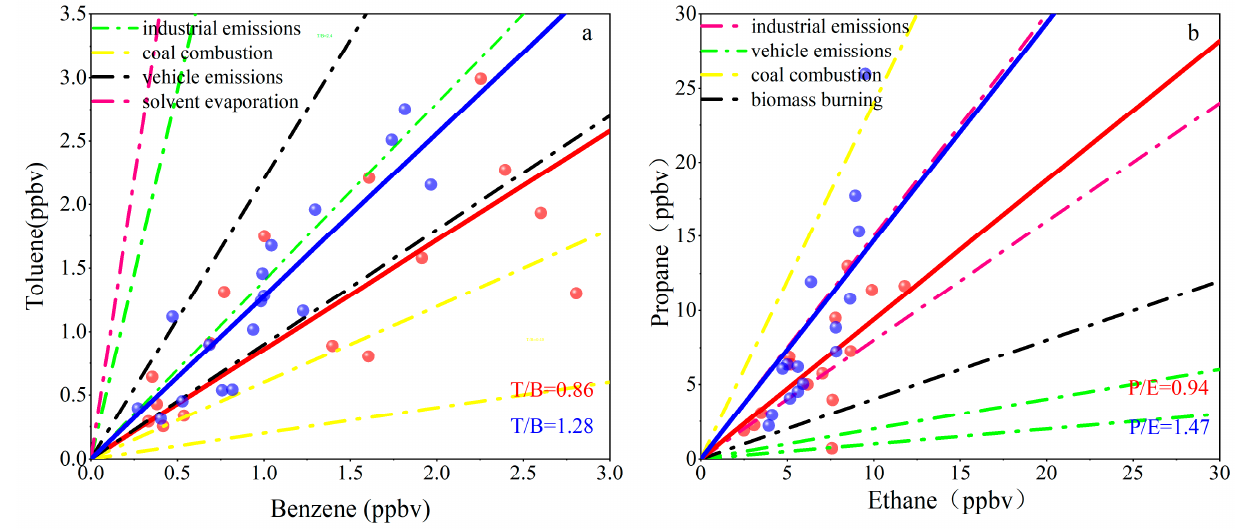
Figure 6. Ratios of toluene/benzene and propane/ethane at the DZ (red) and SS (blue) sites. Propane/ethane ratios of 0.2–0.4 and 1.5–2.4 were associated with biomass burning and coal combustion [12,62]. The range of 0.1–0.2 and 0.8–1.5 for propane/ethane were considered as vehicle emissions and industrial sources [61,63]. In this study, the average ratios of propane/ethane at DZ and SS sites were 0.94 and 1.27 (Figure 6b), with ratios within the industrial emission interval, indicating that industrial emissions contribute significantly to atmospheric propane and ethane in this area, which was consistent with the sampling sites being located near industrial